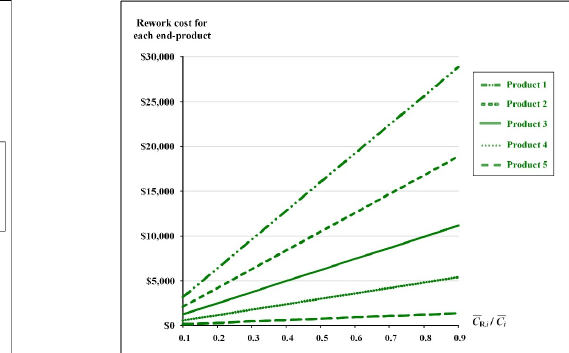
Fig. 15. The impact of ( P T1,0 / P 1,0 ) on key cost contributors in E [ TCU ( T A *, n *)]